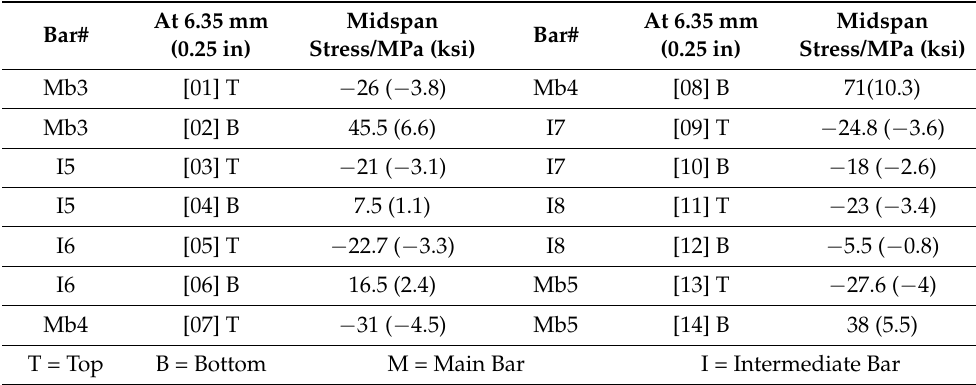
Table 1. Stresses located 6.35 mm (0.25 in) from the top and bottom